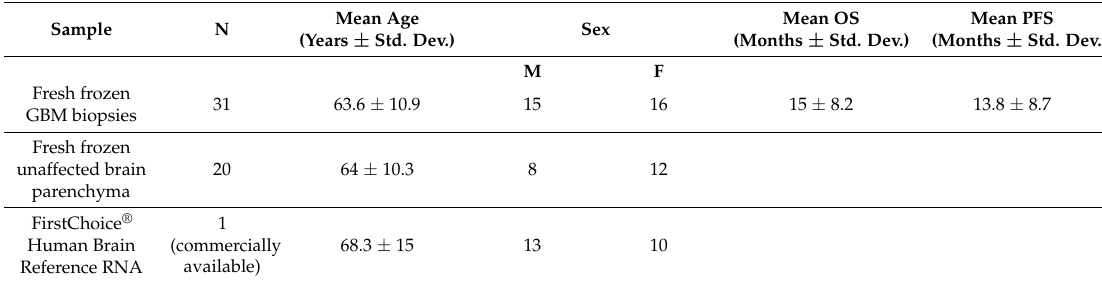
Table 1. Clinical data of Glioblastoma (GBM) and control